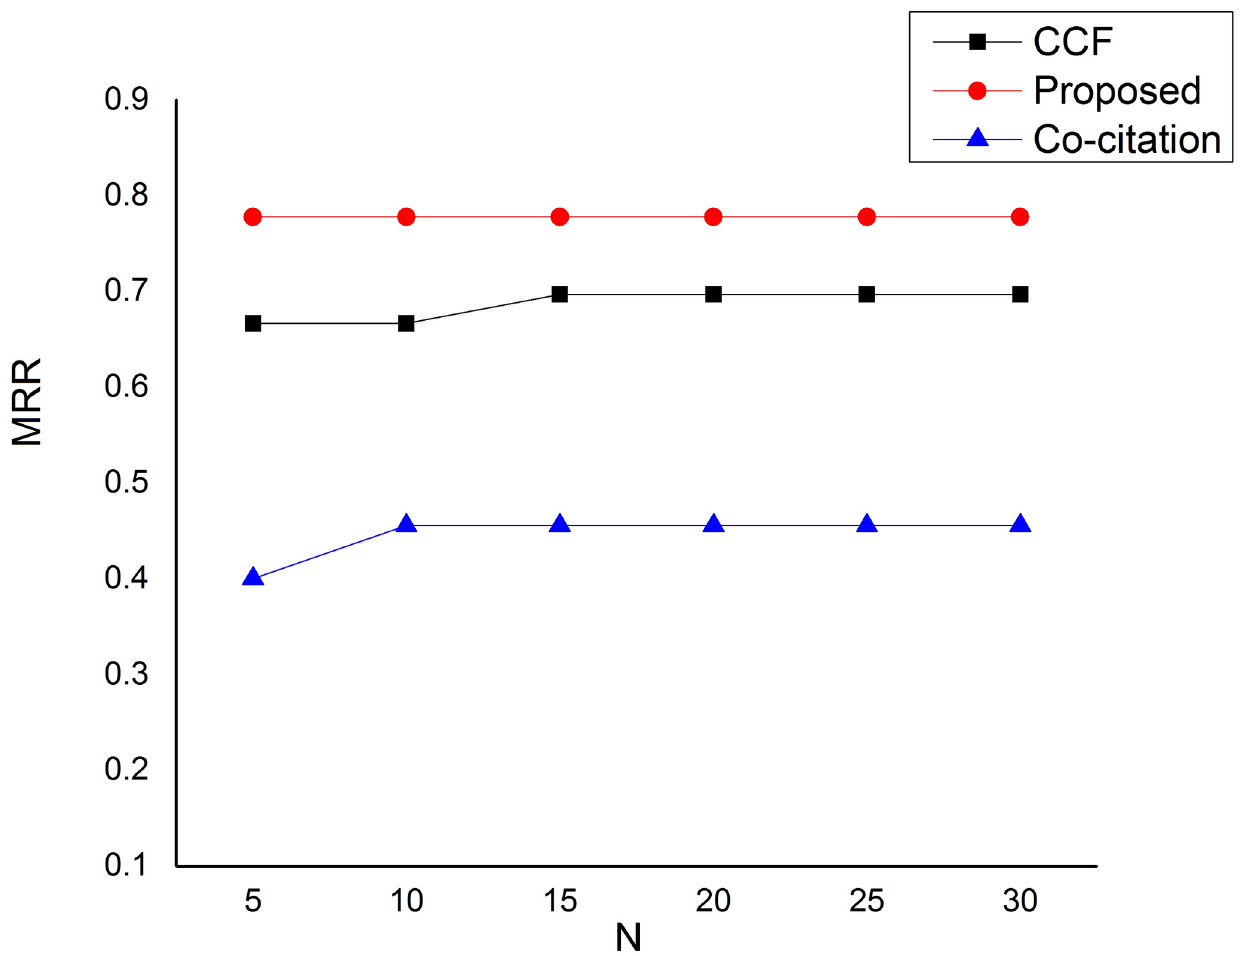
Fig 6. Mean Reciprocal Rank (MRR) performanceon the